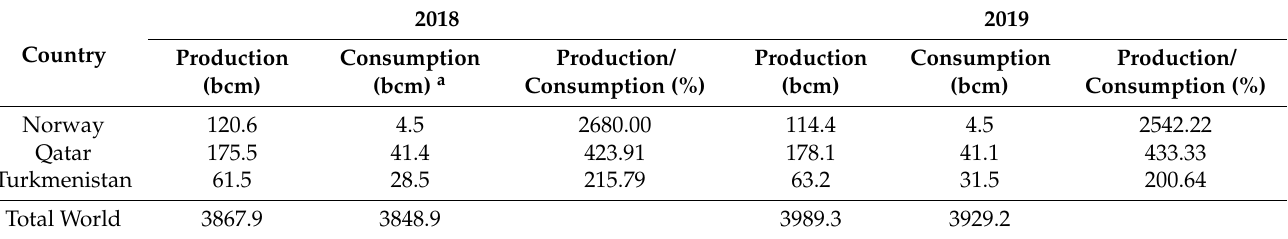
Table 1. Countries with the largest surplus of gas produced in 2018 and